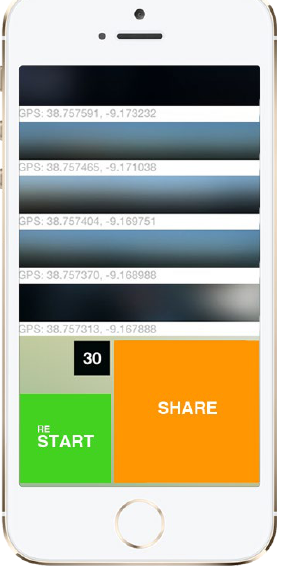
Fig. 11. User Interface: share